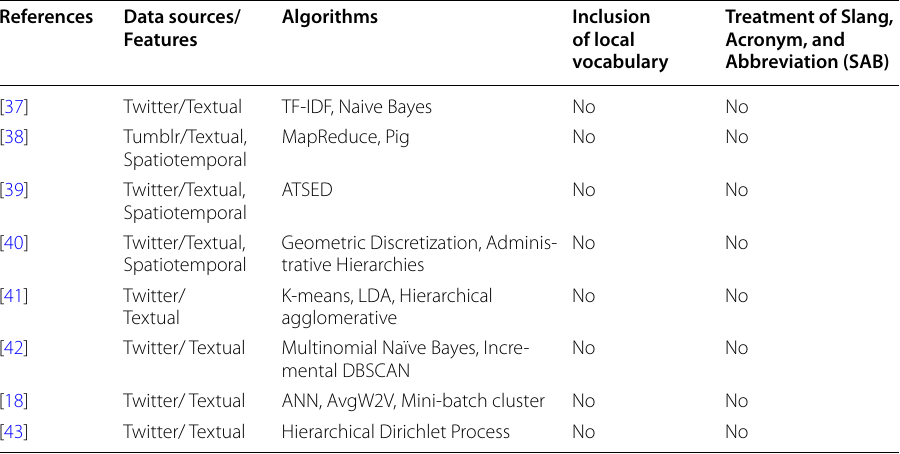
Table 2 Semi-supervised learning approaches used for event